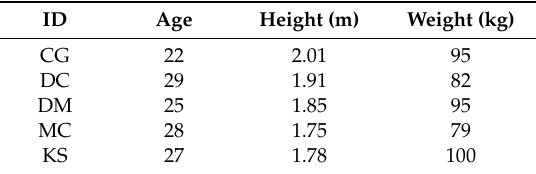
Table 1. Participant demographic data